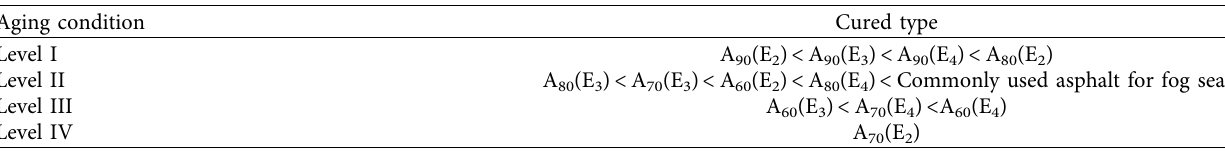
Figure 14: The morphology of the cured product of the fog seal asphalt after photothermal aging. (a) Level I aging (small wrinkles and bubbles). (b) Level II aging (significant bubbles, surface depression). (c) Level III aging (large folds). (d) Level IV aging (fracture). Table 9: Photothermal aging status.